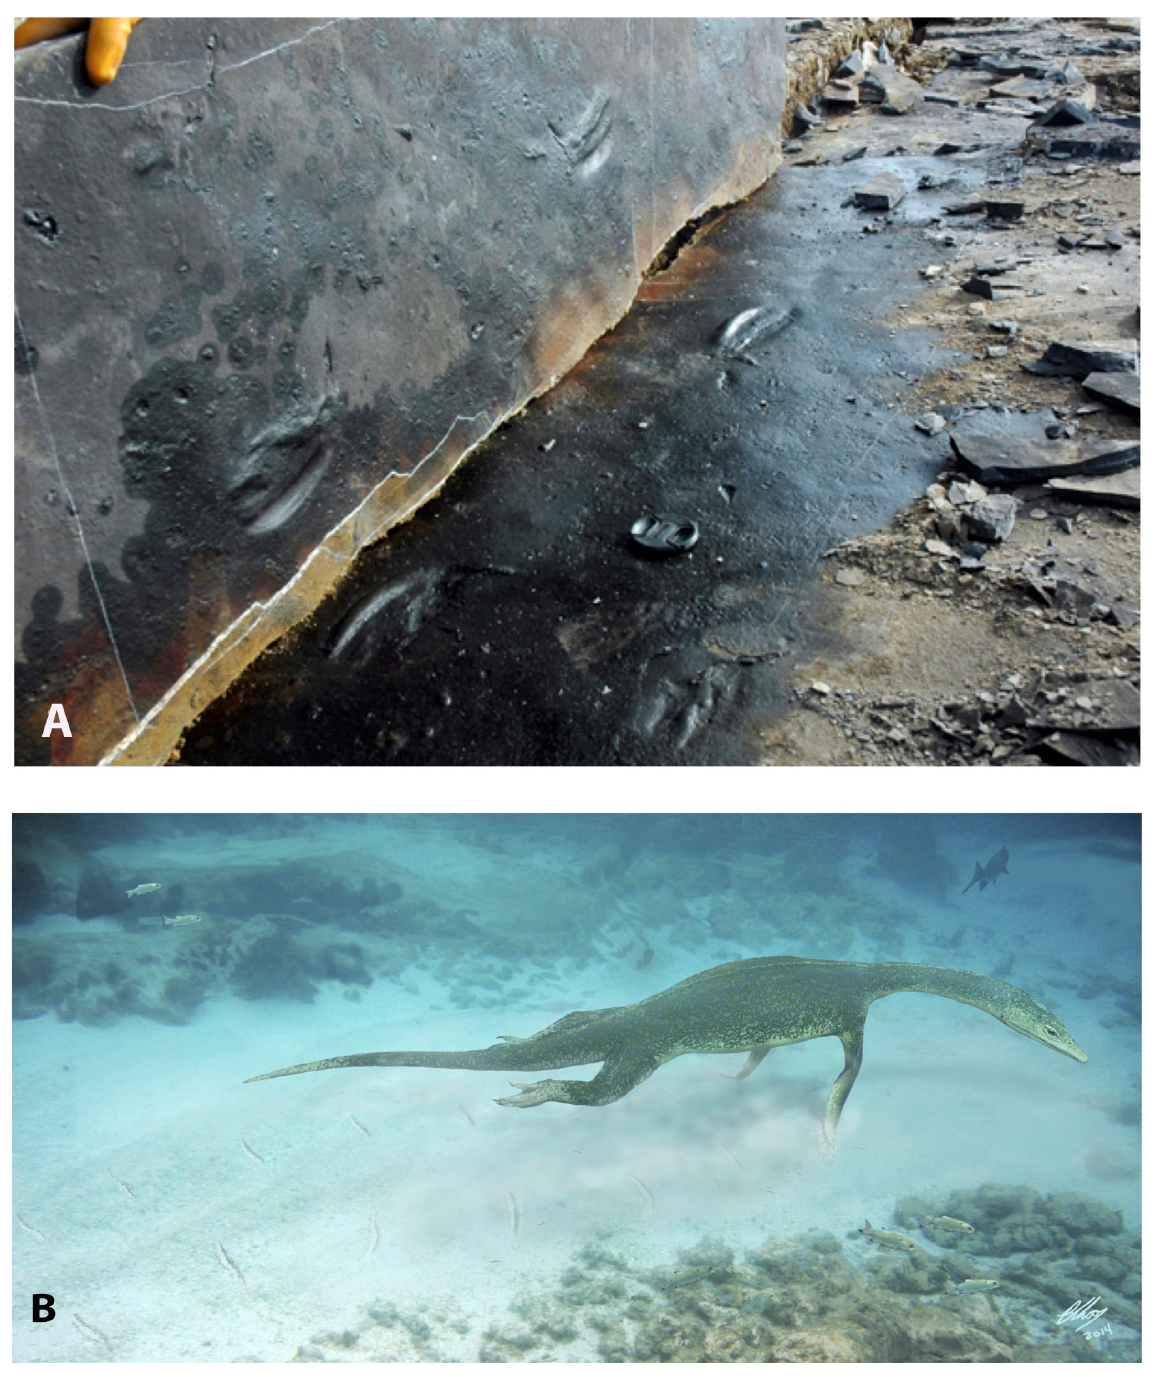
Figure 9. Pair of forelimb punt marks made by a large nothosaur, like Nothosaurus zhangi , showing appearance and size when slab is lifted A), and reconstruction of the animal in life B). Photograph by Q.Y.Z.; artwork by Brian